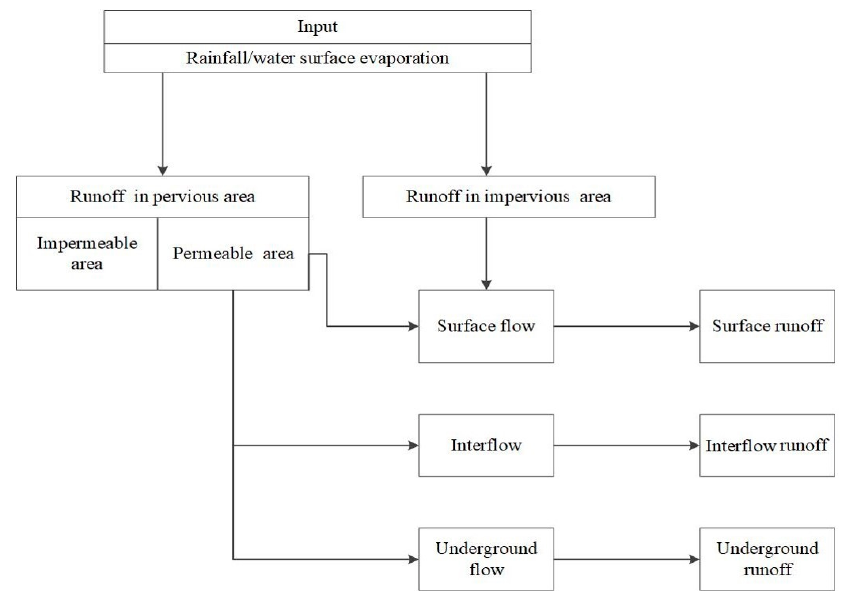
Figure 3. Structure of the process by which saturation excess runoff is produced.